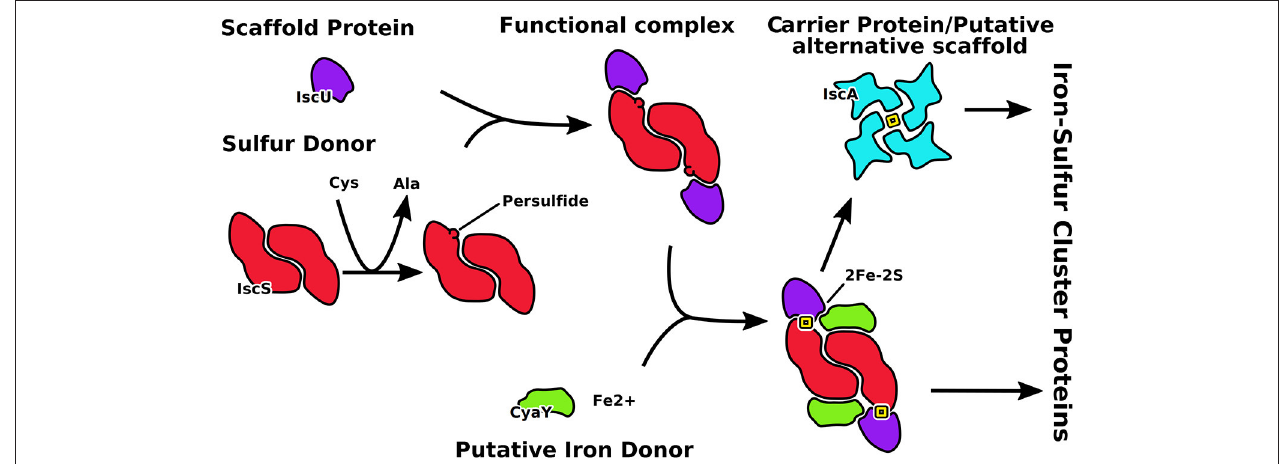
FIGURE 1 | Schematic representation of the role of the proteins described in this work. IscU is the scaffold on which the cluster forms after catalysis of the desulfurase IscS to produce S 0 . CyaY regulates the speed of clutser formation. IscA is an alternative scaffold which takes the cluster from